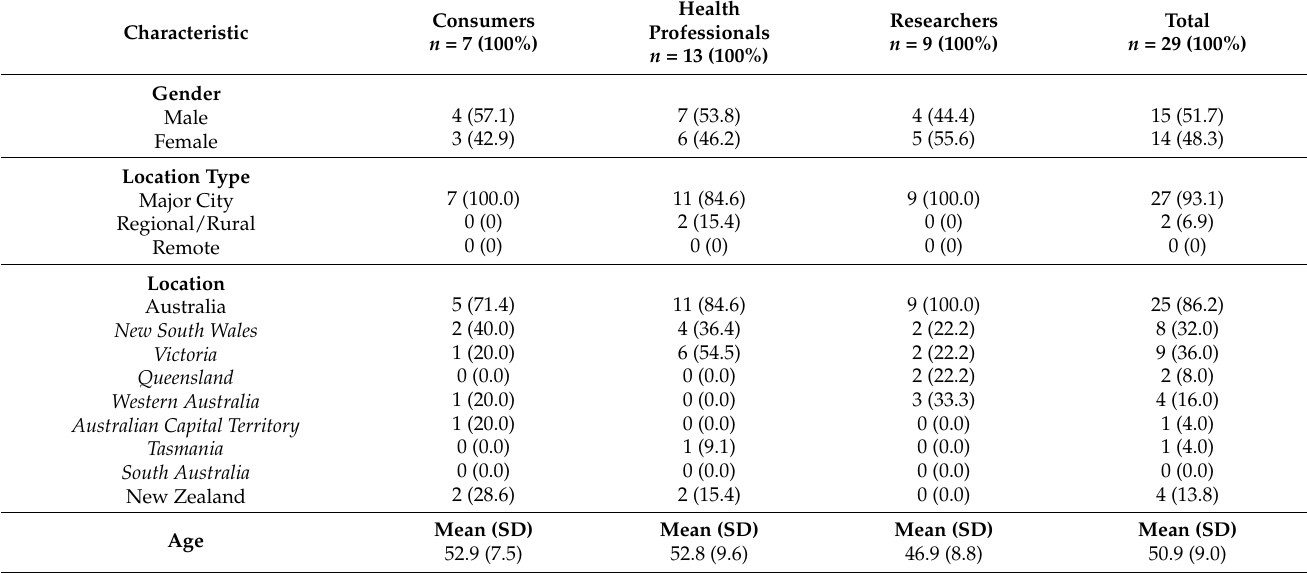
Table 2. Phase 1, Step 2 demographics for focus